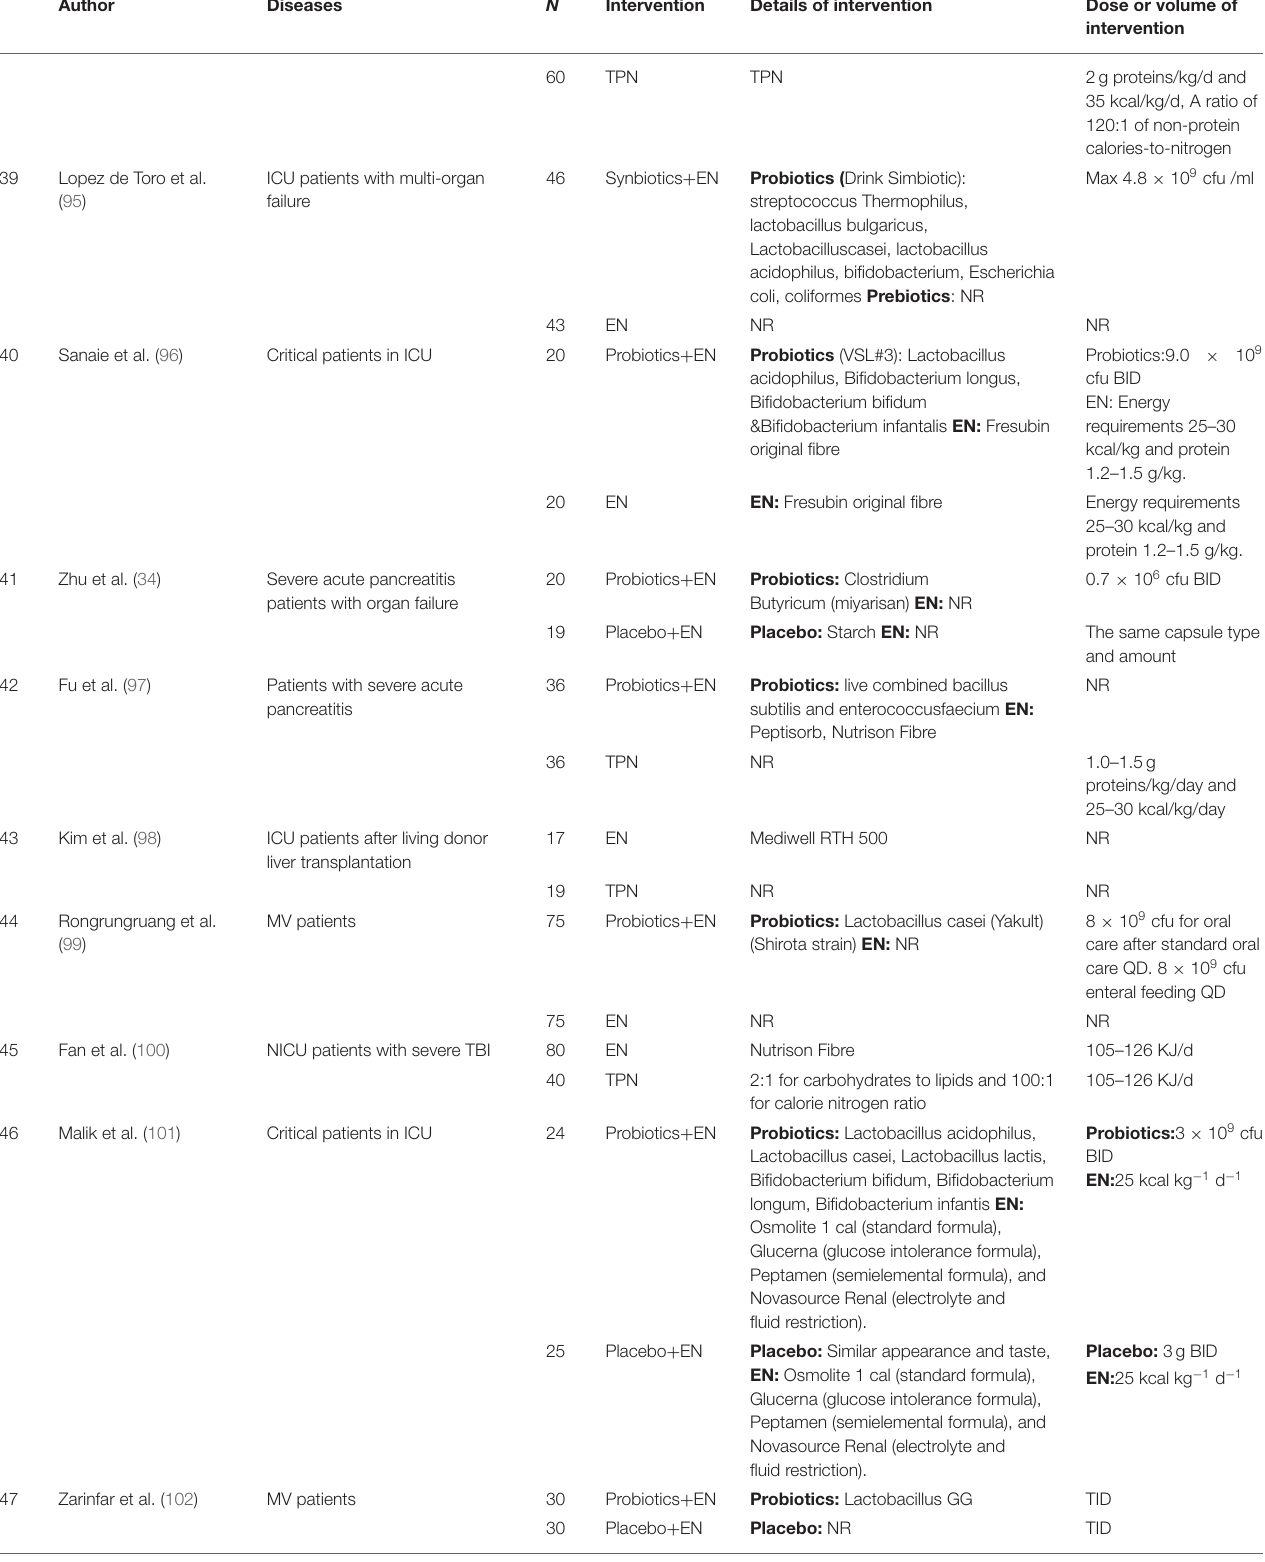
120:1 of non-protein calories-to-nitrogen